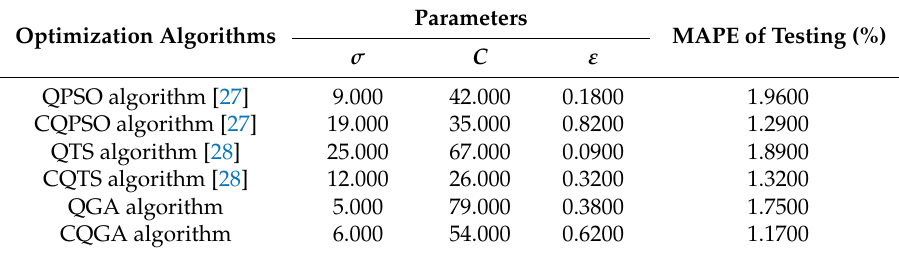
Table 8. Determined parameters of SVRCQGA, SVRQGA, and other models (Example 3).